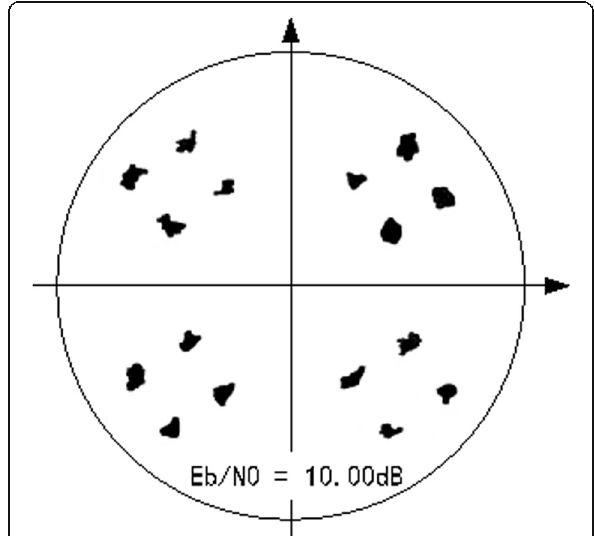
Fig. 12 Before filtering (10 dB polarization interference). This figure shows a constellation graph before filtering (10 dB polarization interference)